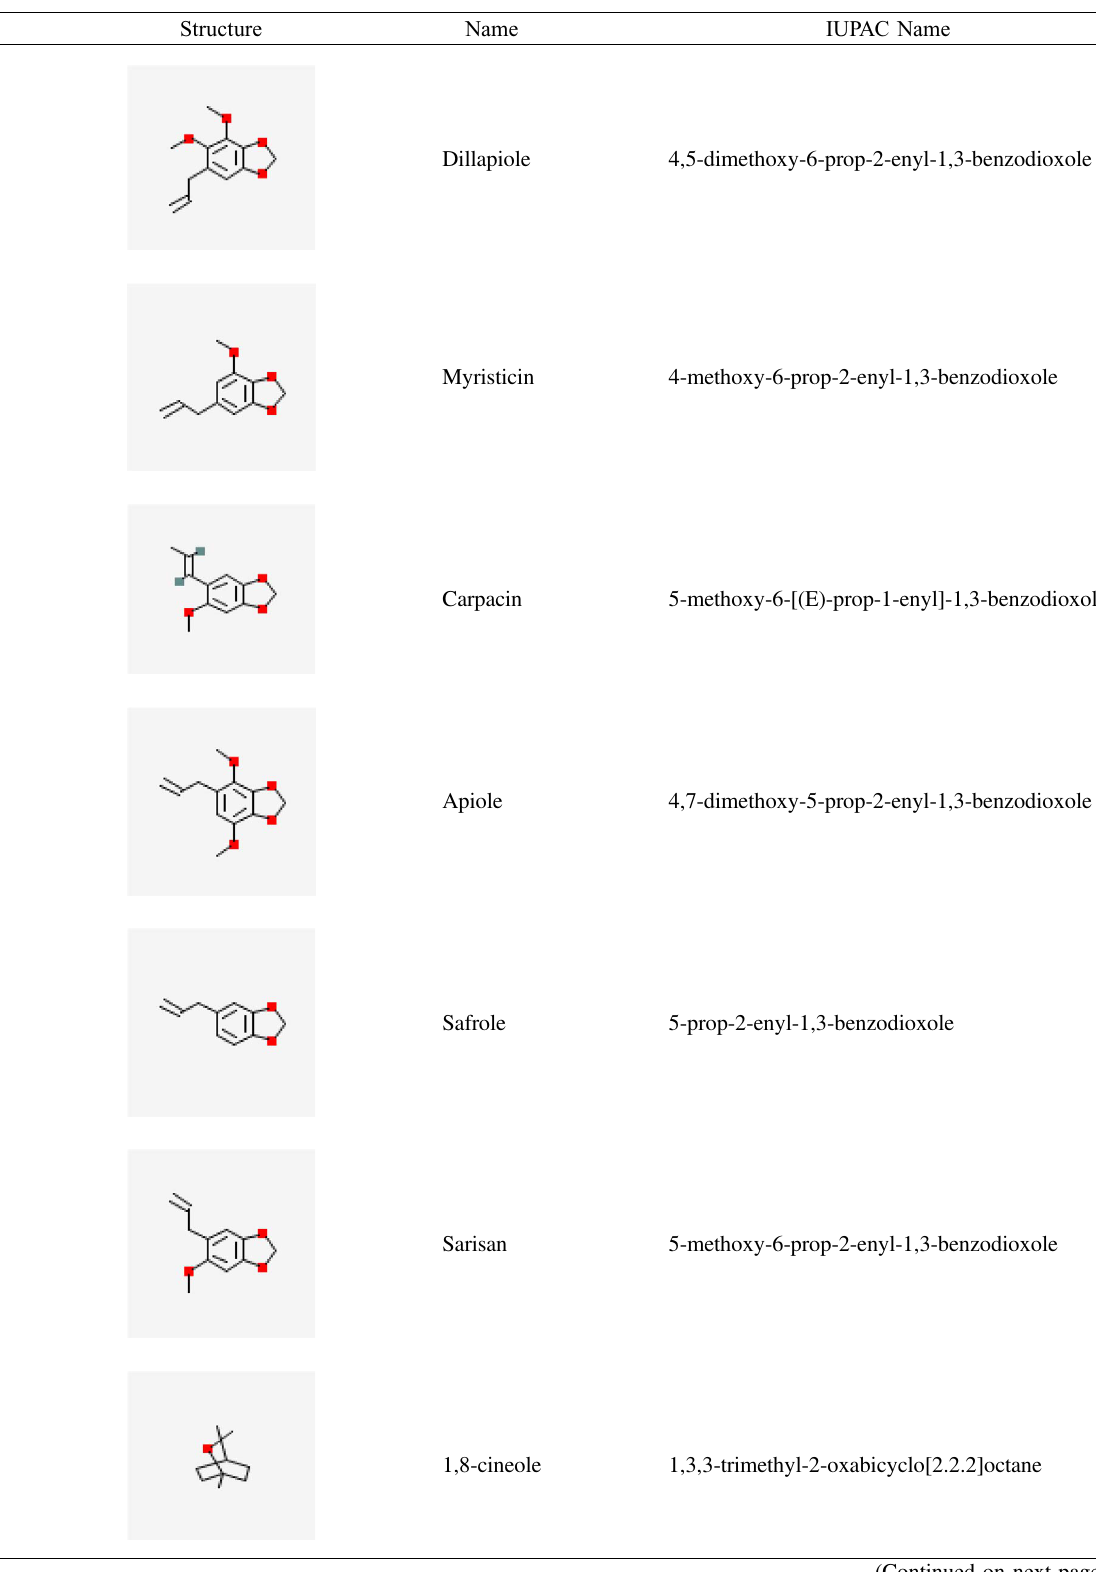
Table 1. Chemical structure of the main components of P. aduncum essential oil . From the PubChem database (https://pubchem.ncbi.nlm.